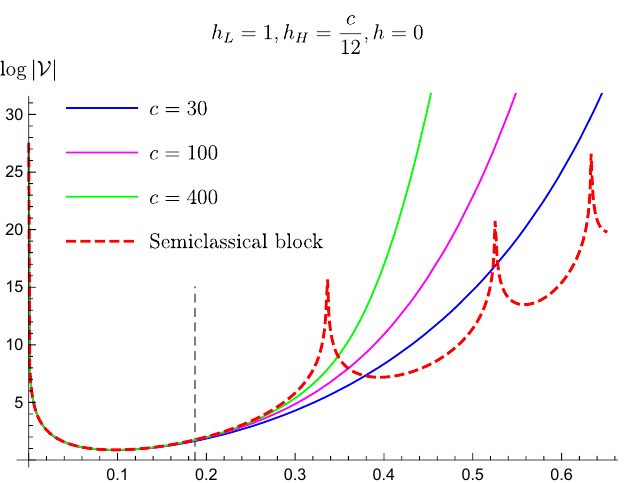
Figure 15 . In this plot, we compare the exact and semiclassical blocks. One can see that at the positions of the semiclassical forbidden singularities, the exact blocks are smooth. Fixing h L and h H as we increase c , the exact blocks approach the semiclassical block in the region between the c origin and the (cid:12)rst forbidden singularity. However, beyond the (cid:12)rst forbidden singularity the exact blocks deviate greatly as we increase c . This indicates that we have passed a Stokes line (emanating from the forbidden singularity) and some other semiclassical saddle dominates the exact blocks in the large c limit. The gray line is the position of t = i(cid:12) 2